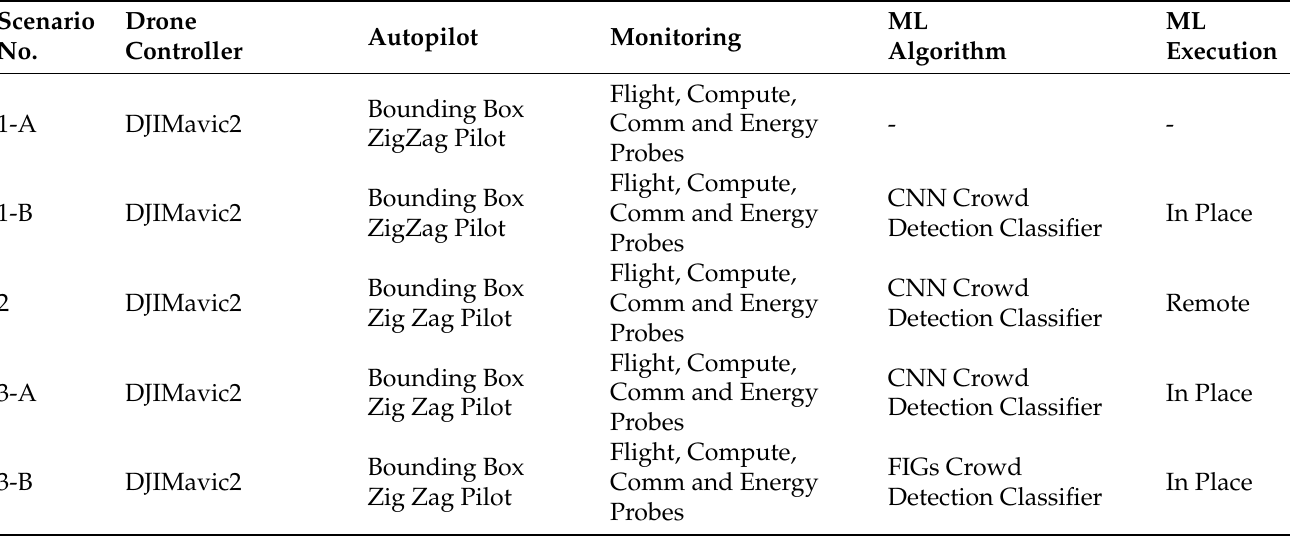
Table 2. Use-case scenarios key configurations for